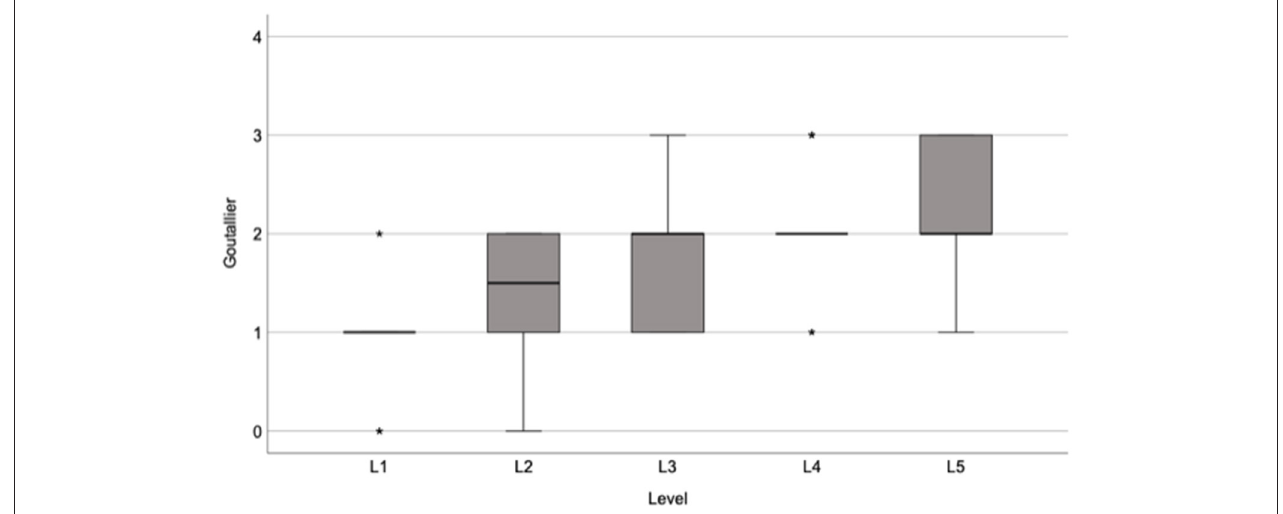
FIGURE 3 | Box plot showing the median and interquartile range of Goutallier grades at each level of the lumbar spine.